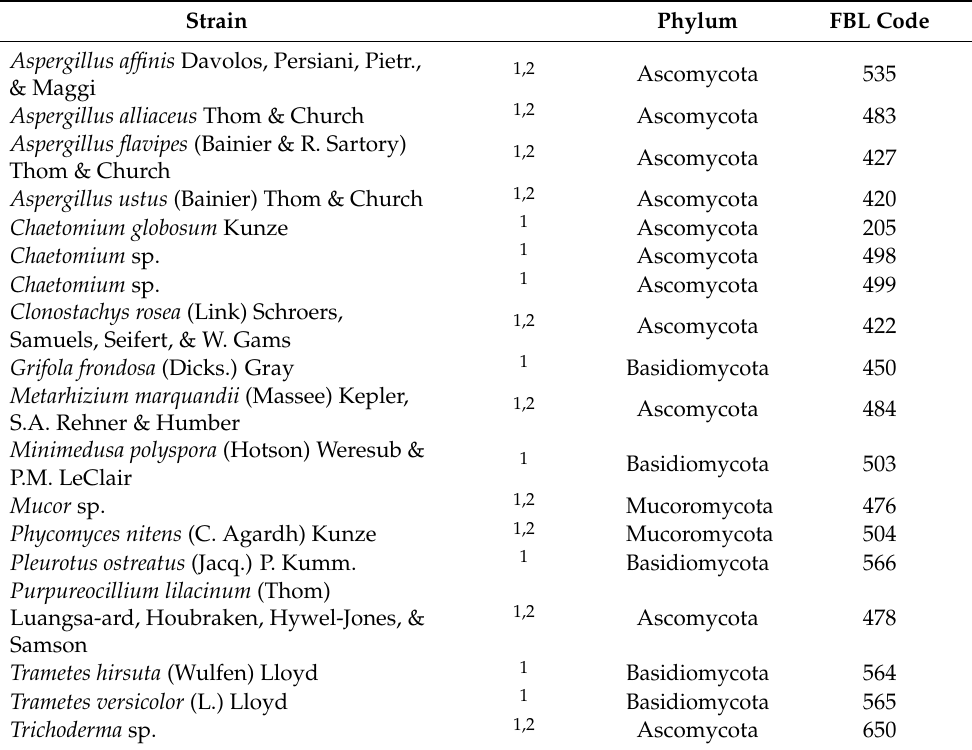
Table 1. Fungal strains selected for the study. 1 Fungal strains tested for Roundup (RU) tolerance; 2 fungal strains tested for their ability to use RU as nutritional sources of C or